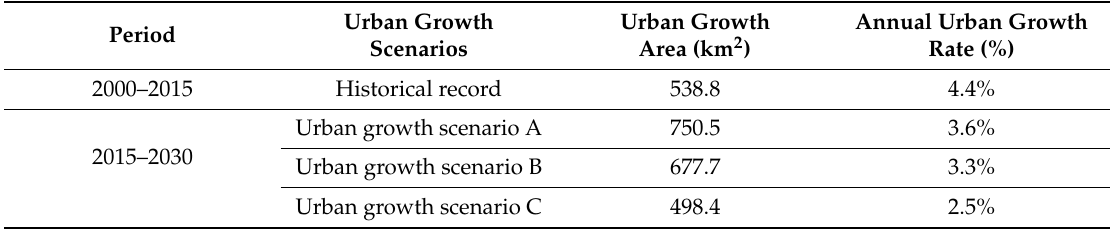
Table 11. Statistics of urban growth